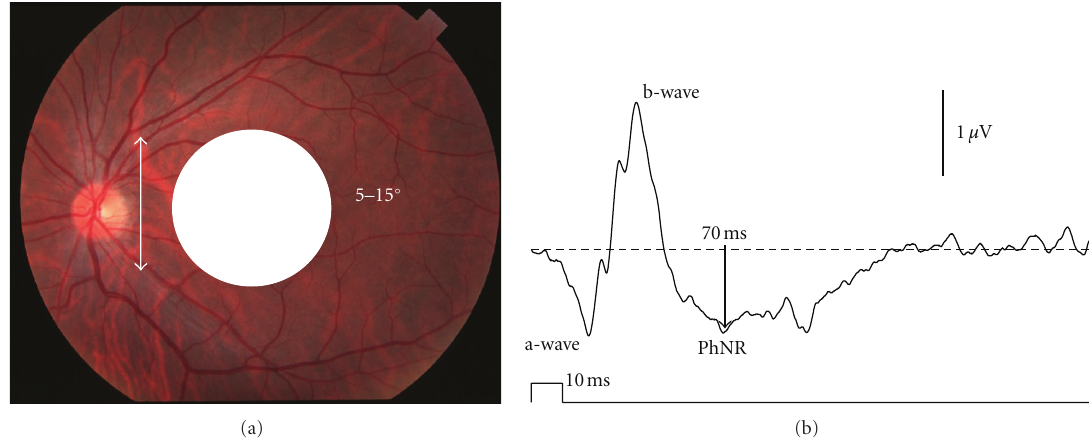
Figure 2: (a) Stimulus spot centered on the macula for recording the focal macular electroretinogram (ERG). (b) The focal macular ERG consists of the a- and b-waves and photopic negative response (PhNR).